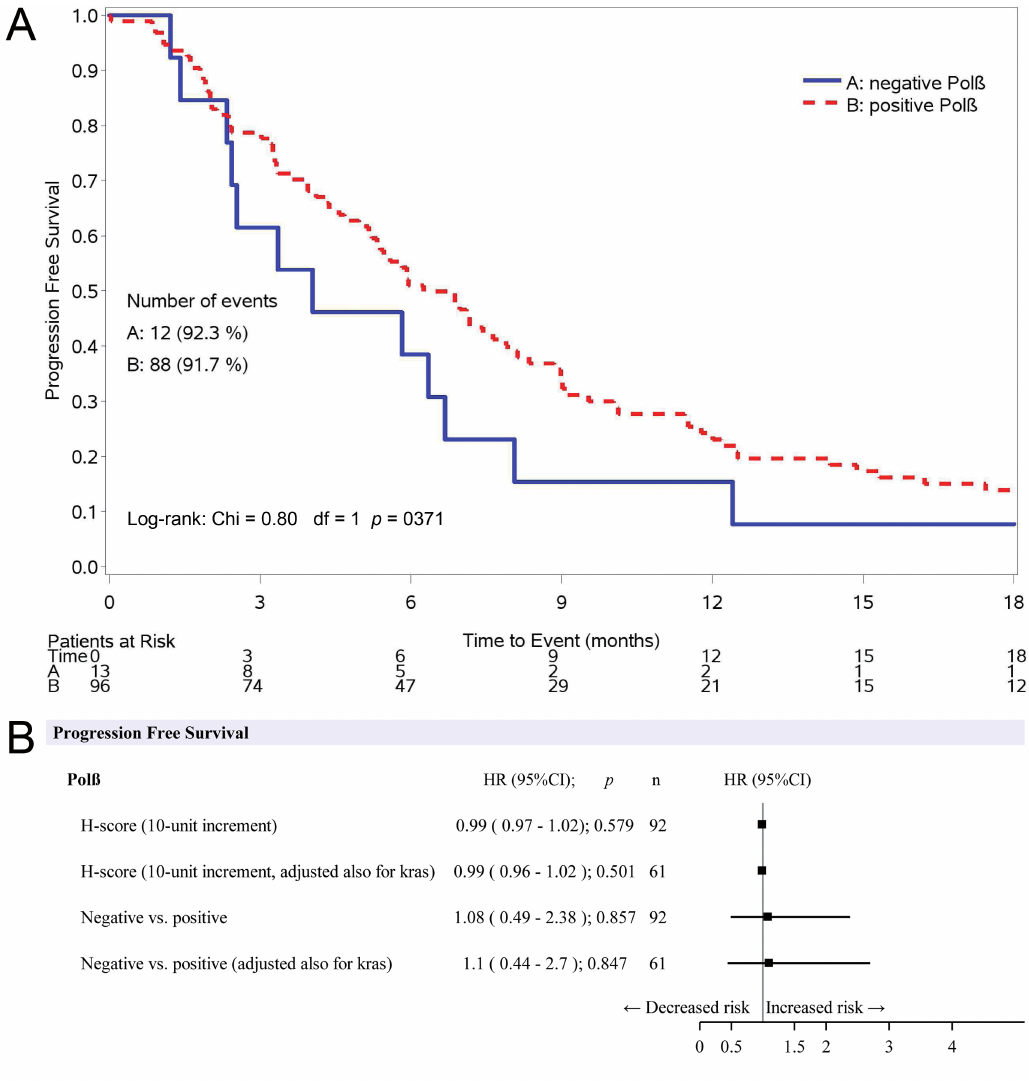
Figure 2. ( A ) Kaplan–Meier curves for PFS according to the positive or negative DNA polymerase β staining. ( B ) E ff ect of KRAS status on the relationship between Pol β and PFS adjusted for ECOG-PS, age, histology, smoking, and